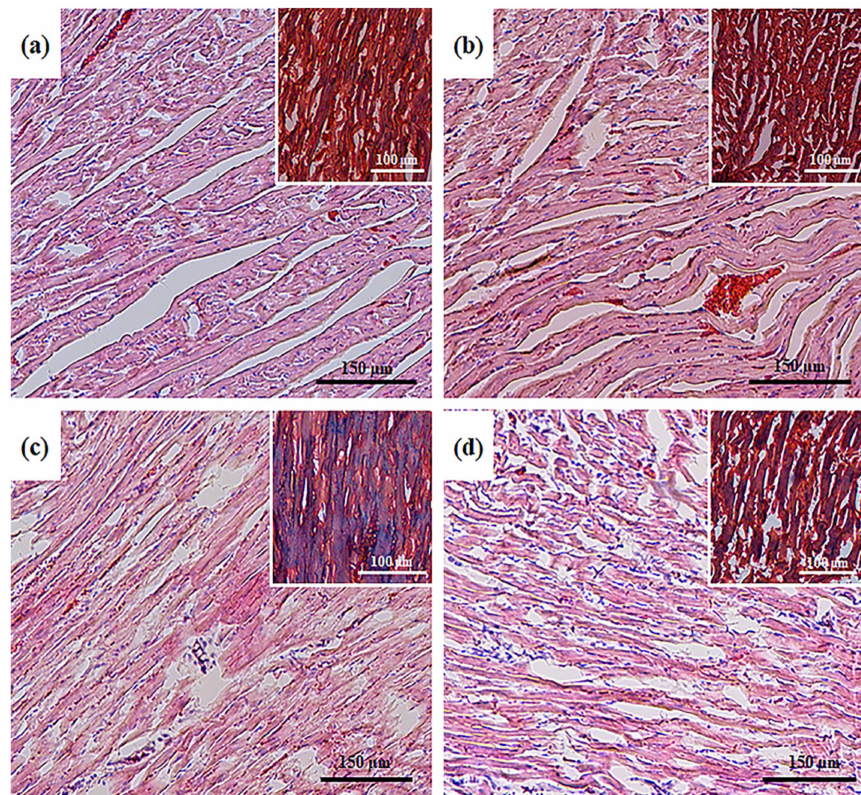
Figure 1. Histological samples of heart ventricles in rats of the control and experimental groups. ( a ) control, group 1; ( b ) chronic astaxanthin (AST) pretreatment, group 2; ( c ) Isoproterenol (ISO) injection, group 3; ( d ) ISO injection and chronic AST pretreatment, group 4. Light microscopy; the main figures show samples stained with hematoxylin and eosin (H&E, cell nuclei are colored blue, erythrocytes are colored red, and muscle tissue is colored pink); internal insets: Masson’s trichrome staining (collagen / fibrosis is colored blue, muscle and other tissues are colored red, cell nuclei are colored